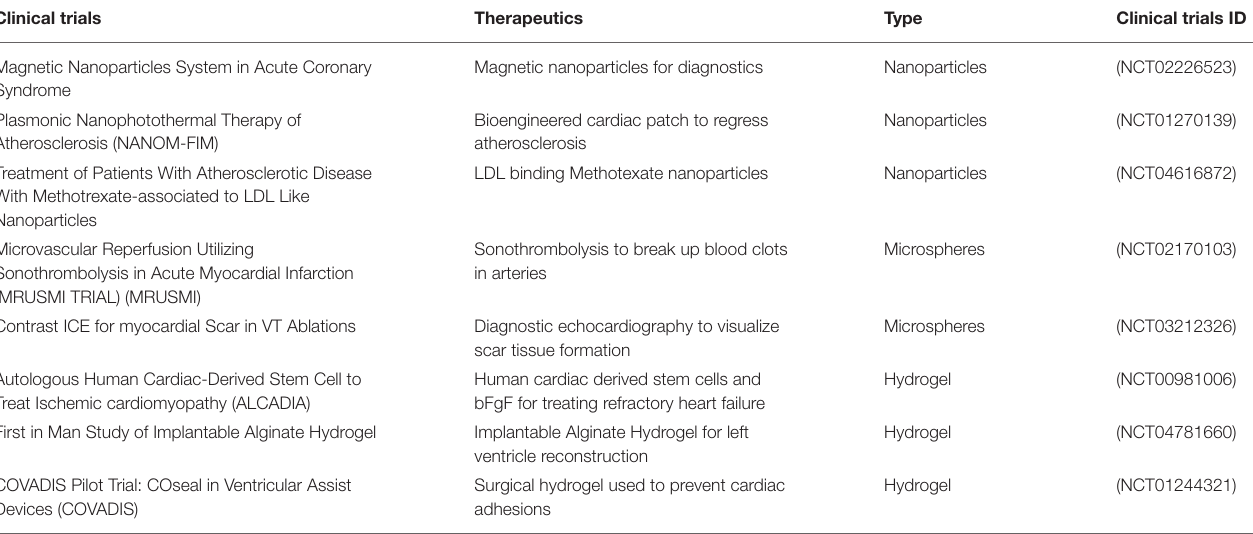
TABLE 4 | Clinical studies conducted on nano/micro particles and hydrogels for cardiac related